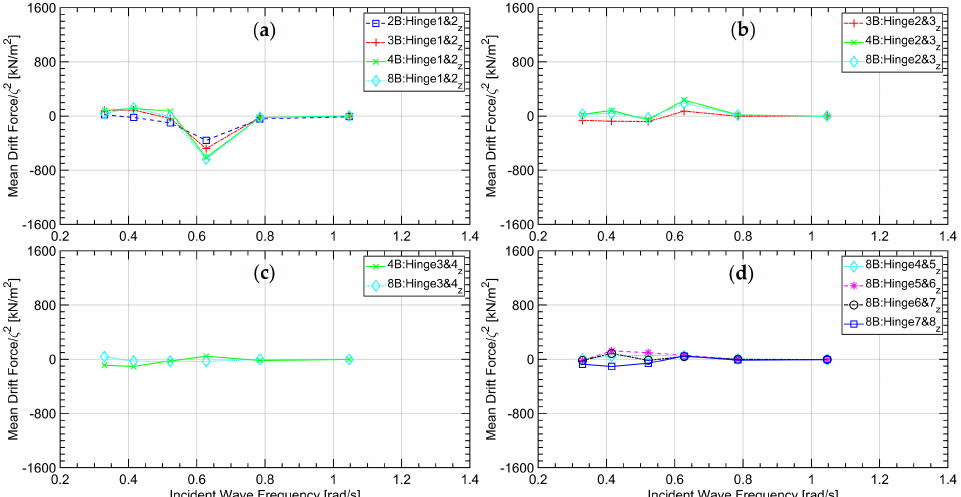
Figure 15. Second-order hinge forces in vertical direction of the five test cases for the chain configura- tion, where n B denotes the configuration with n bodies; m & n , the hinge connecting m -th body and n -th body; subscript z , the hinged forces in z direction: ( a ) between 1st and 2nd modules; ( b ) between 2nd and 3rd modules; ( c ) between 3rd and 4th modules; ( d ) between 4th and 5th , 5th and 6th , 6th and 7th , 7th and 8th modules.